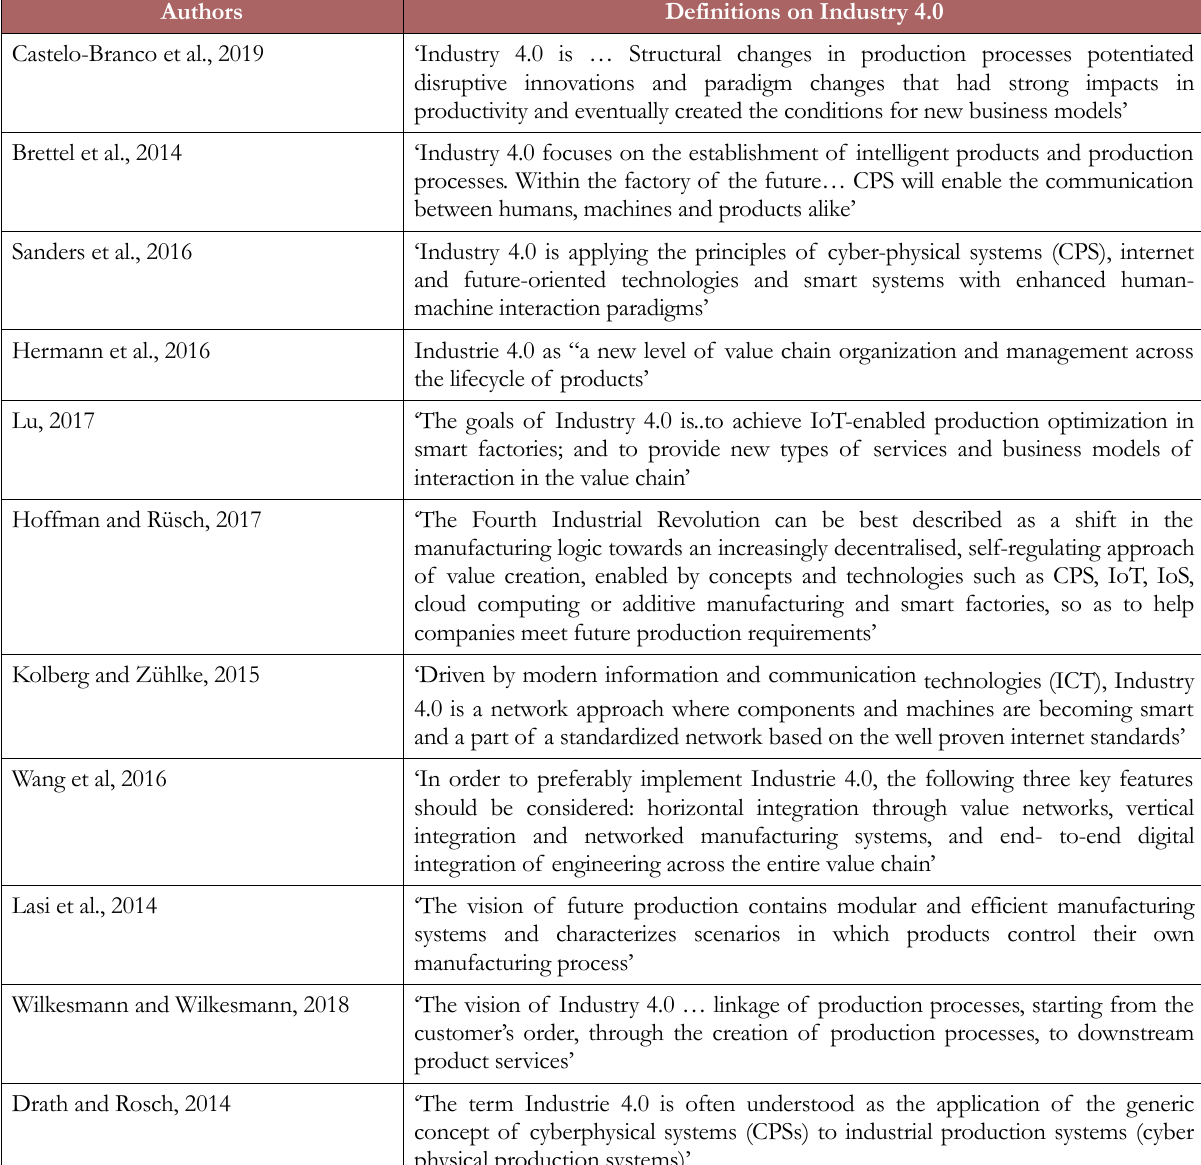
Table 1. Extent definitions of Industry